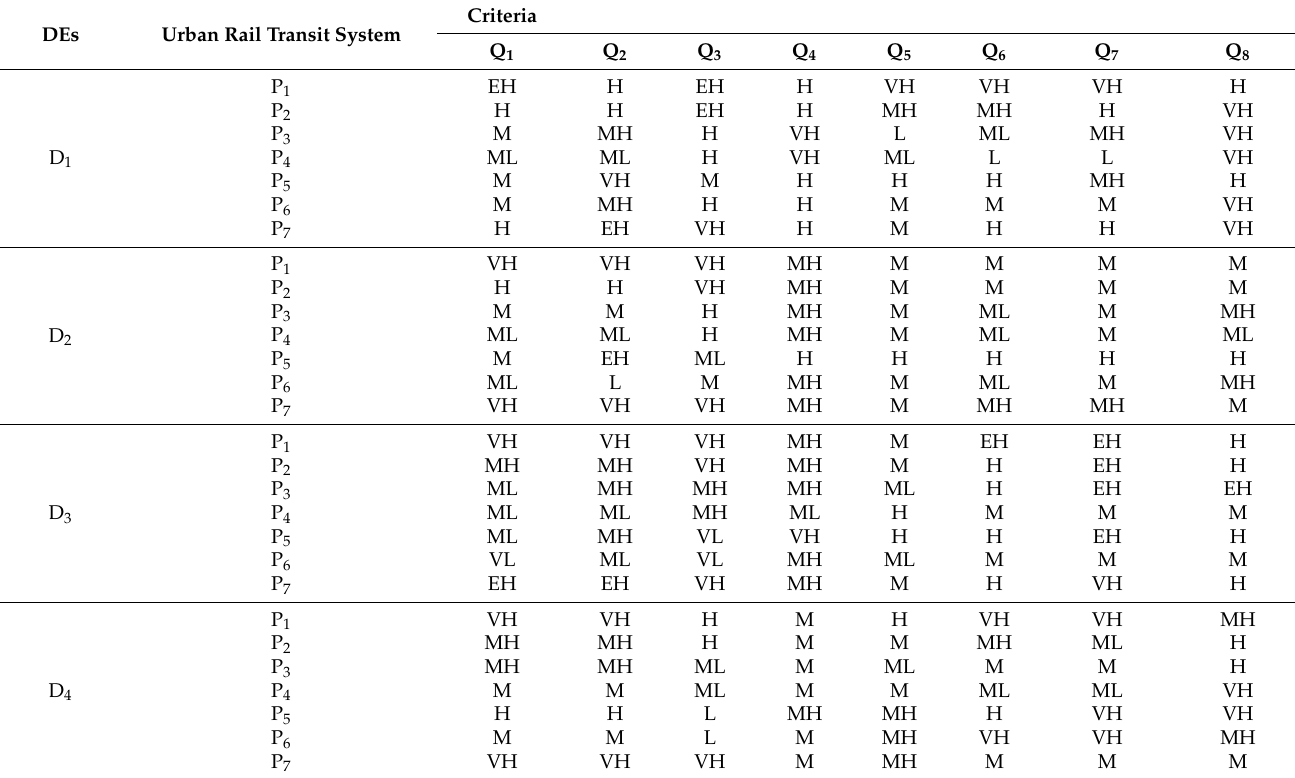
Table 4. The linguistic decision-making matrix.